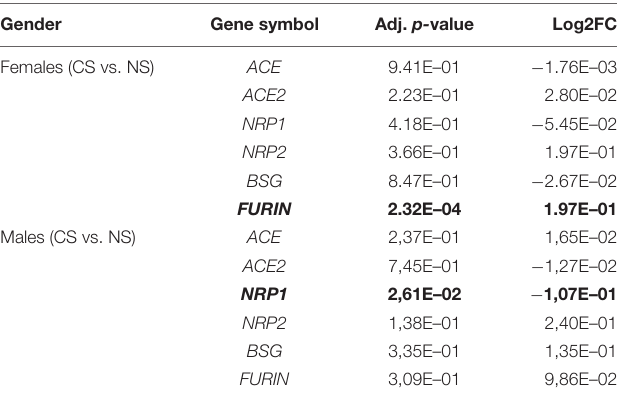
TABLE 1 | Expressions of ACE, ACE2, NRP1, NRP2, BSG, and FURIN in monocytes of human subjects enduring chronic stress (CS) as compared to non-stressed (NS) controls.